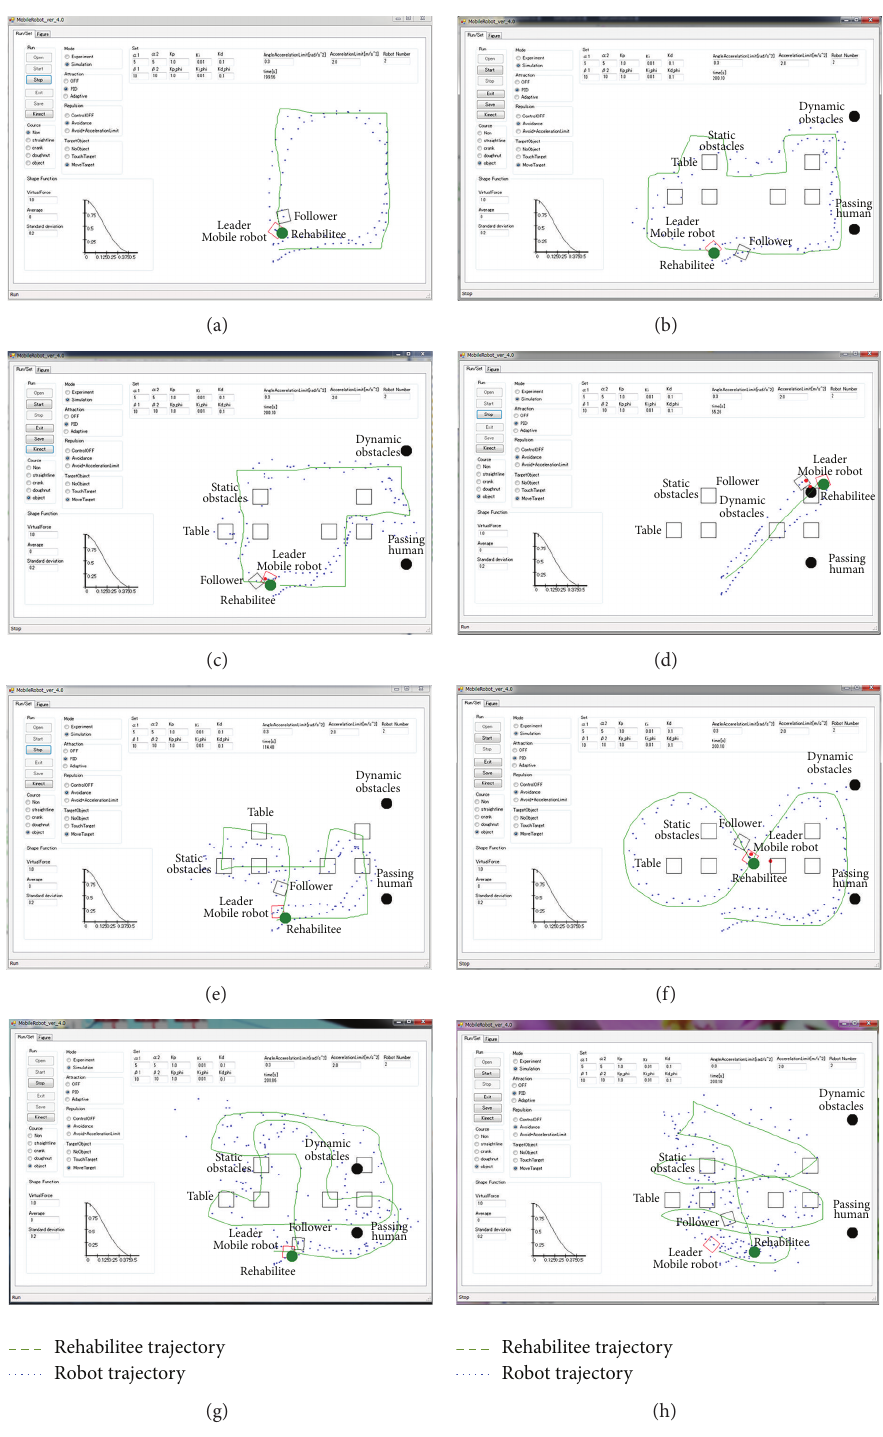
Figure 9: Environment setups in this study to verify the effectiveness.